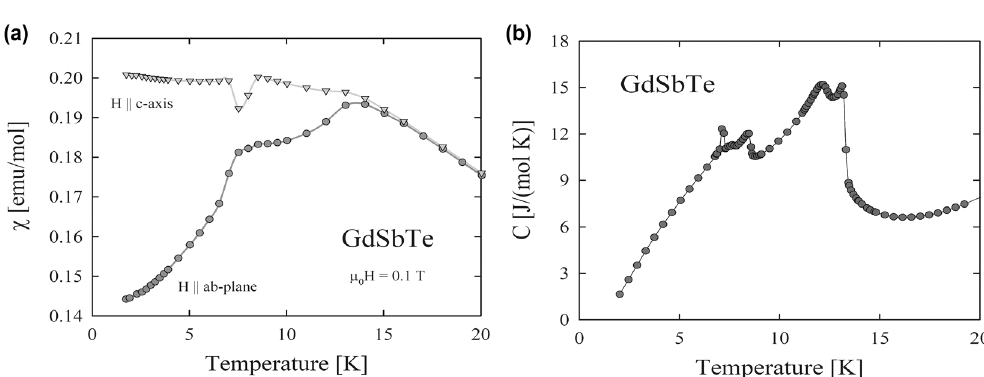
Figure 4. Temperature dependent measurement of dispersion maps along the M-X-M direction. Measured temperature are noted on the plots. Re_8 K indicates the dispersion map after thermal recycle (8 K → 21 K → 53 K → 8 K). All the measurements were performed at the ALS beamline 4.0.3 using a photon energy of 90 eV.